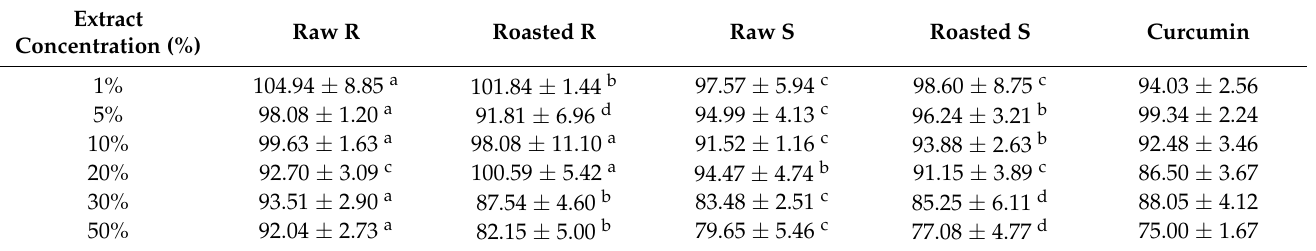
Table 2. Effects of raw and roasted Nigella arvensis (R) and Nigella sativa (S) at different extract concentrations (0, 1, 5, 10, 20, 30, and 50%) on HT-116 cell cancer